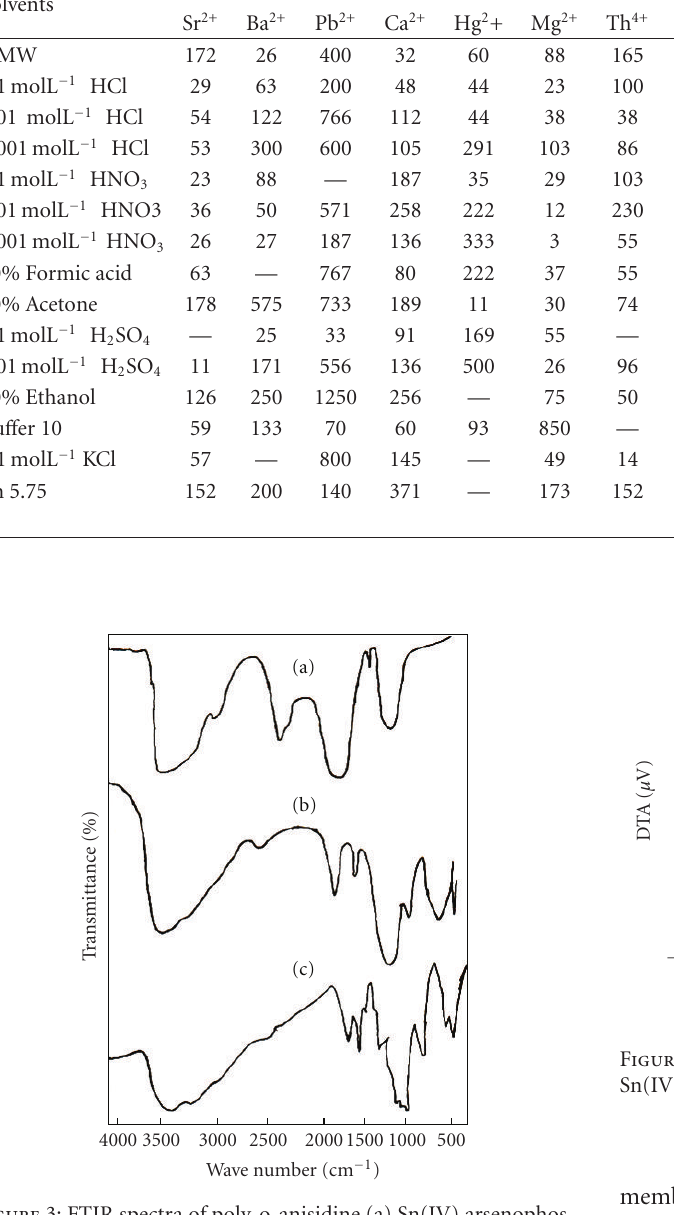
Table 3: K d -values of some metal ions on poly-o-anisidine Sn(IV) arsenophosphate composite cation exchanger in di ff erent solvent systems. Solvents